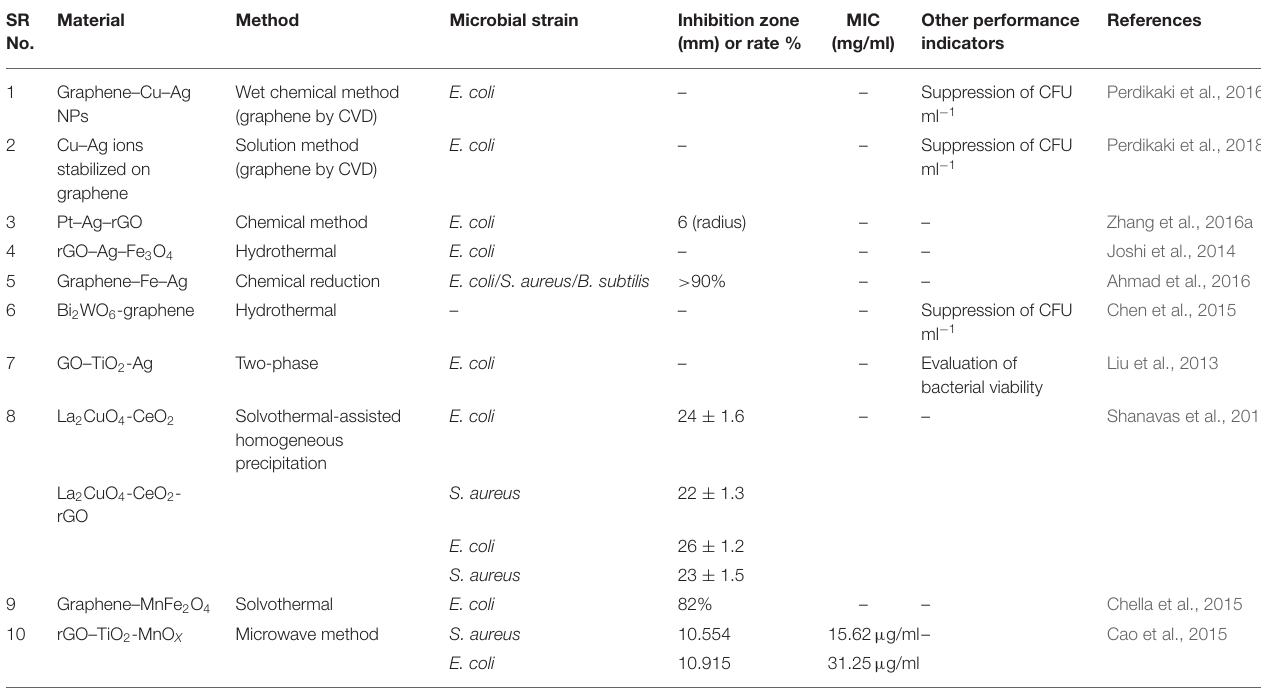
TABLE 5 | Types and antimicrobial properties of graphene-supported bimetallic nanoparticles. SR No.